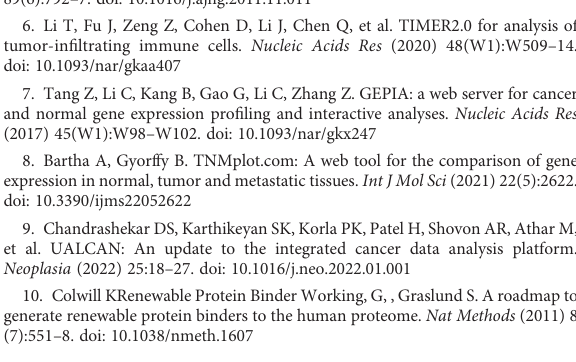
SUPPLEMENTARY FIGURE 6 The expression levels of LIAS and immune checkpoints. (A, B) TIDE database explored the relationship between LIAS expression and in fi ltration of CTL in cancer patients, including bladder cancer patients treated with PD-L1 inhibitor and melanoma patients treated with CTLA4